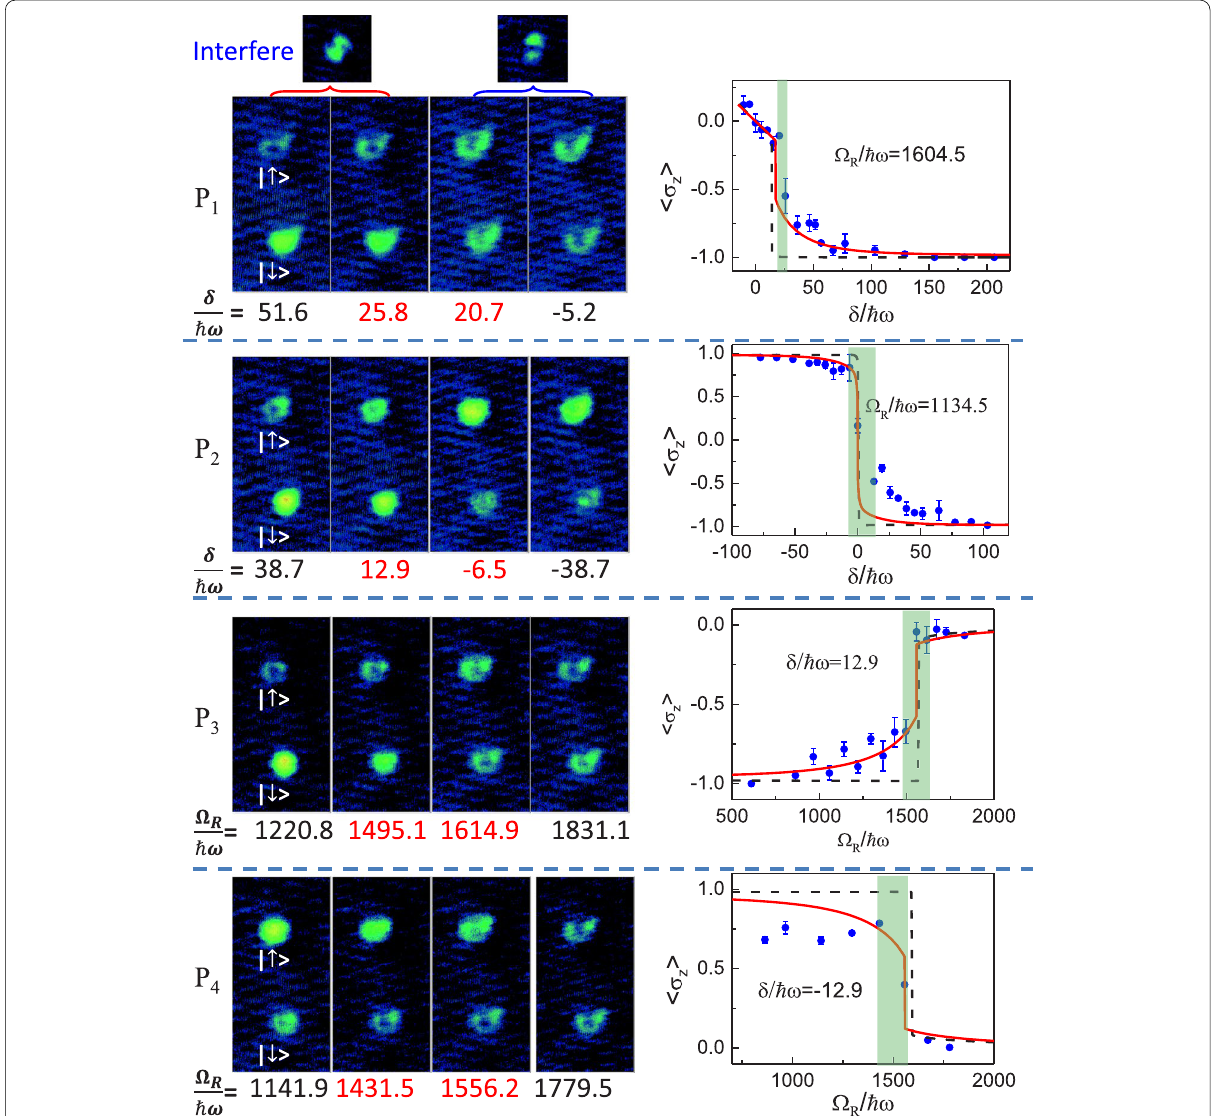
Fig. 17 The spin‑resolved density profiles after a 20 ms TOF expansion across different phase‑transition boundaries along four exemplary paths P 1,2,3,4 (left panel) and the corresponding spin polarization temperature (at finite temperature T / T c